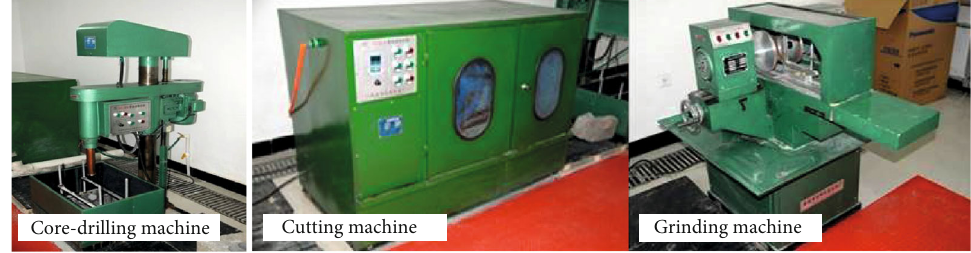
Figure 6: Coal rock test piece processing equipment.